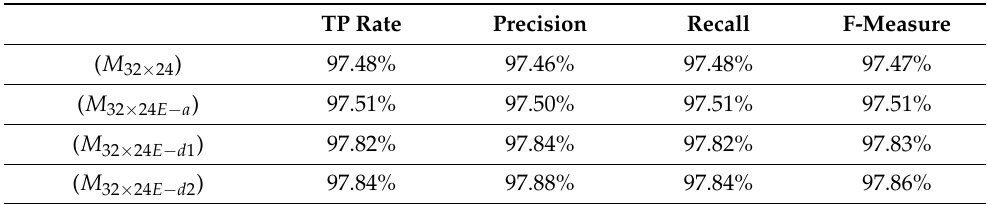
Table 5. The classification TP rate, precision, recall and F1-score of the high-resolution frames during cross-validation for different denoising techniques.